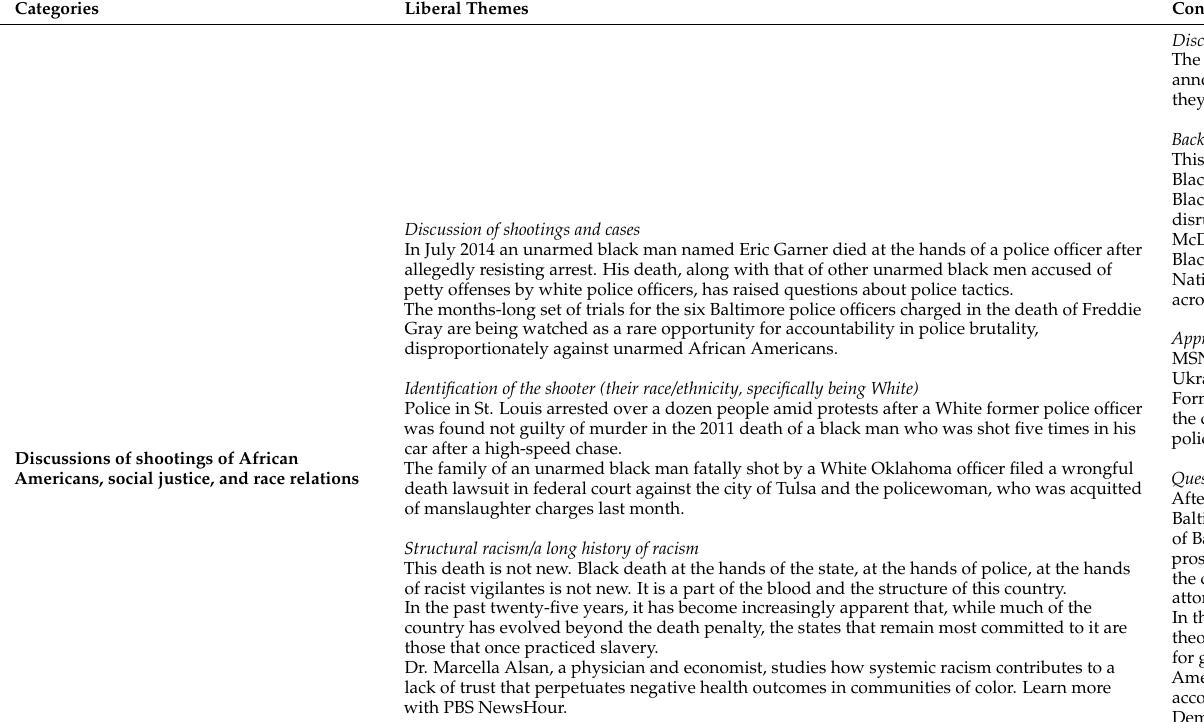
Table 3. Content analysis of themes with illustrative examples by liberal and conservative